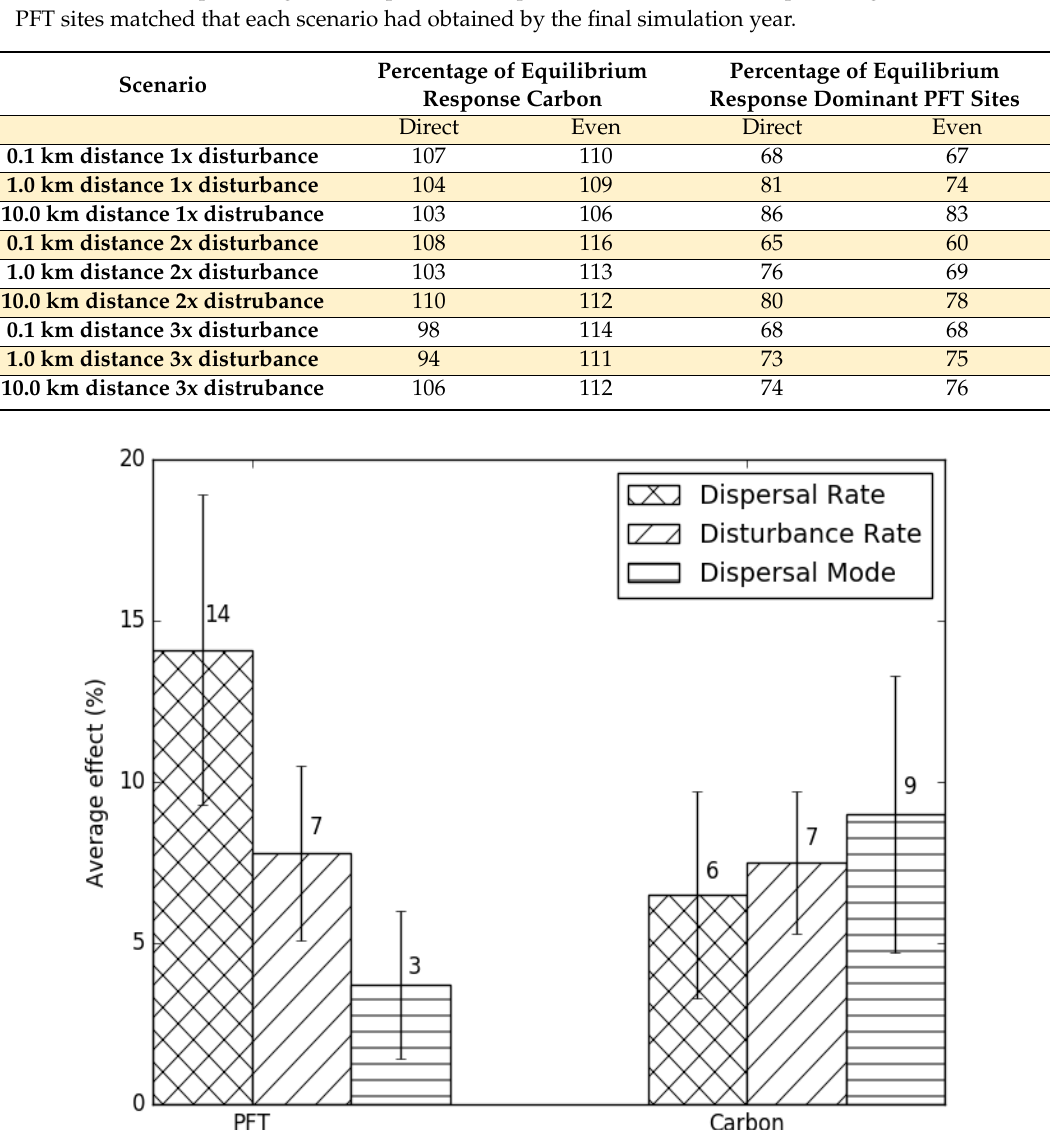
Figure 3. The Root Mean Square Error (RMSE) (% units) of the average effect that each independent variable had on the percentage of the equilibrium responses total carbon and the percentage of dominant PFT sites matched that each transient response scenarios had achieved by the final simulation year.